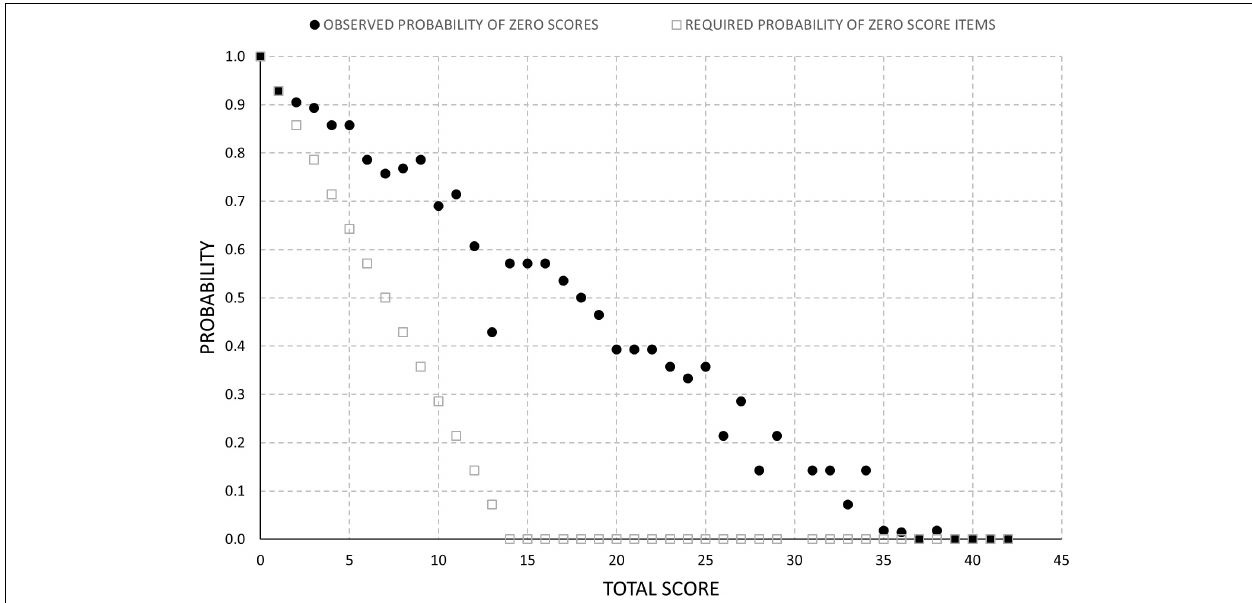
FIGURE 5 | Observed probability of zero scores relative to the minimum probability required to achieve a given total